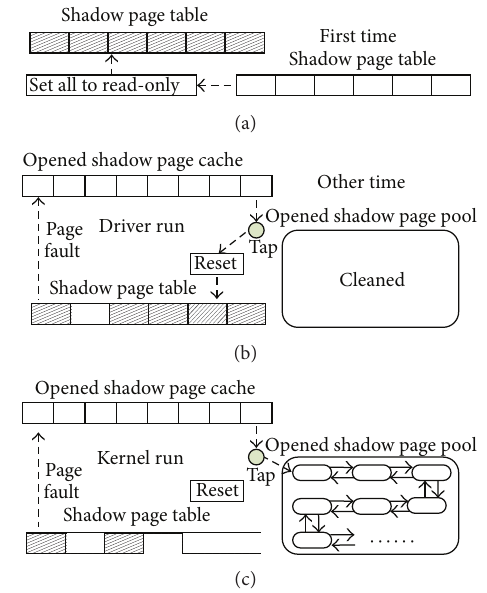
Figure 4: The principle diagram of SCDWC